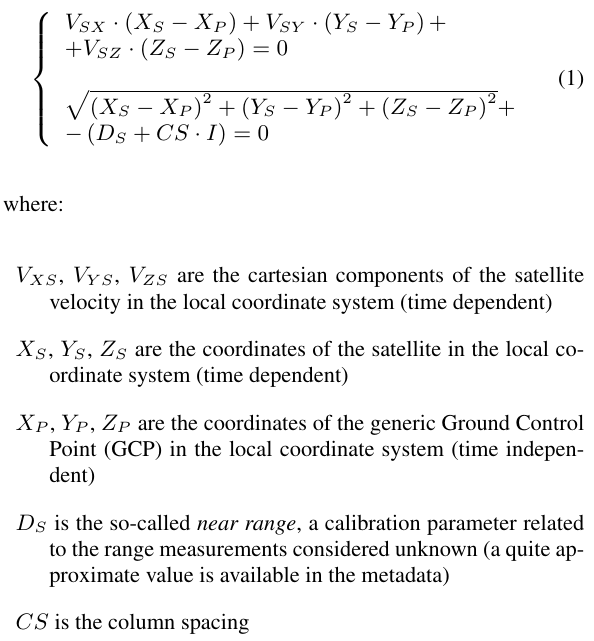
University Hannover, allowing for a full 3D DSM comparison to remove possible horizontal biases too, using as ground reference the LIDAR DTM by the “Provincia Autonoma di Bolzano” free available